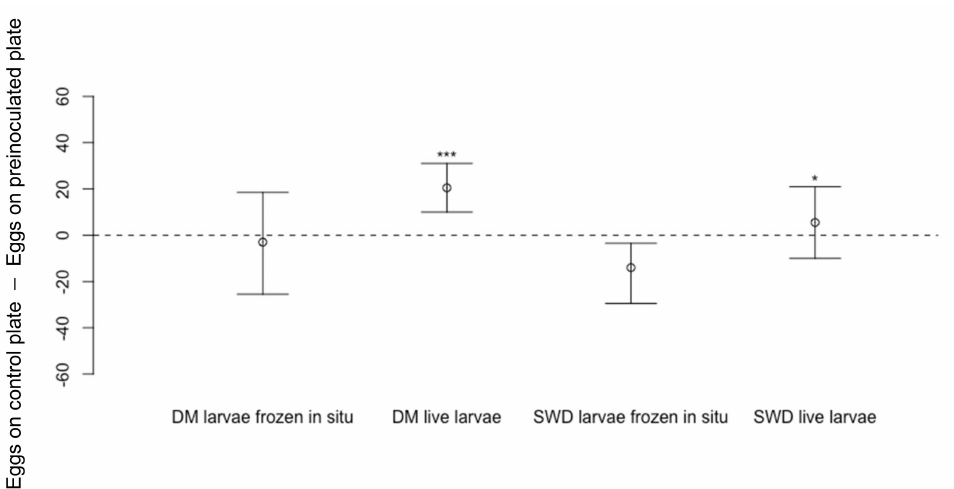
Figure 11. Differences in numbers of eggs laid by Drosophila suzukii (Median ± 95% confidence intervals) on cornmeal media dishes with larvae killed by freezing in situ of D. melanogaster (DM) ( n = 18, p = 0.62) or D. suzukii (SWD) ( n = 18, p = 0.41). Numbers of eggs laid by D. suzukii were lower on dishes containing live D. melanogaster (DM) larvae ( n = 18, p < 0.001 ***) or live D. suzukii (SWD) larvae ( n = 18, p < 0.05 *) compared to eggs laid on blank